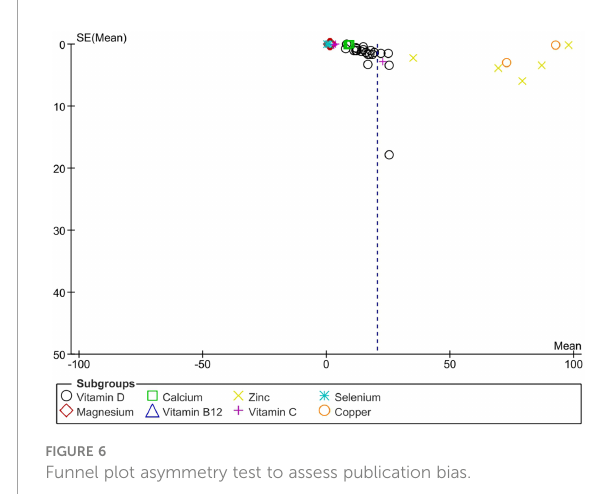
FIGURE 6 Funnel plot asymmetry test to assess publication bias.